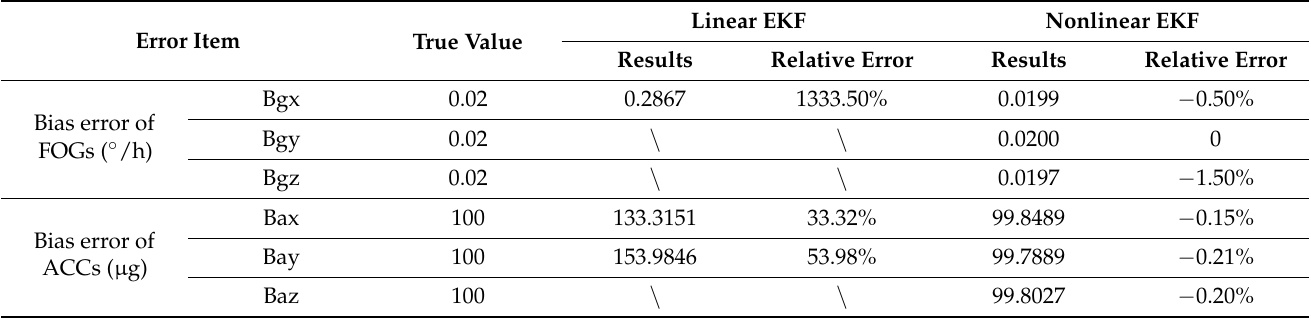
Table 3. The estimated results of all the error